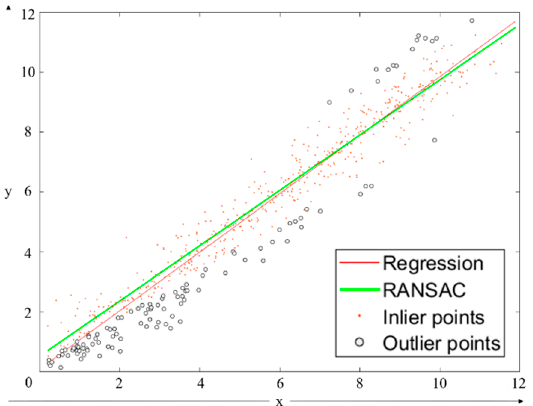
Figure 2. Comparison regression line with the result of RANSAC. RANSAC: random sample consensus.